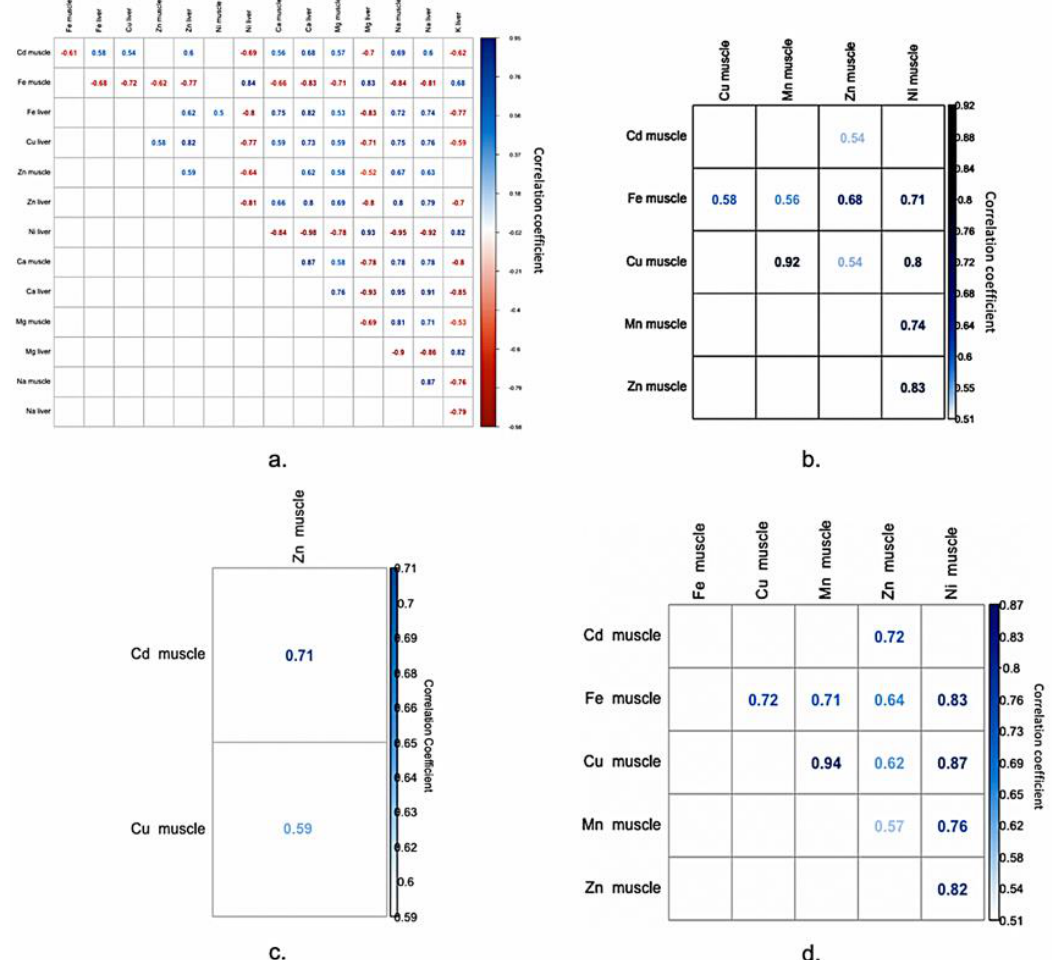
Figure 1. Correlation matrix of heavy metals concentration in turbot tissues (( a ) correlation matrix for the first group samples; ( b ) correlation matrix for the second group samples; ( c ) correlation matrix for the third group samples; and, ( d ) correlation matrix for the fourth group samples).